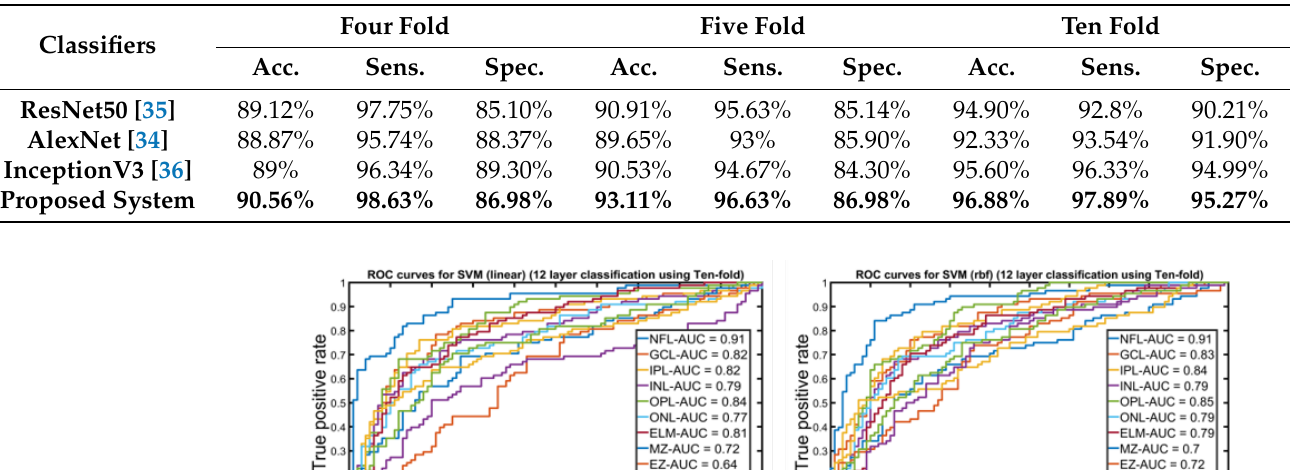
Table 3. Comparison between the proposed system and other state-of-the-art deep learning ap-